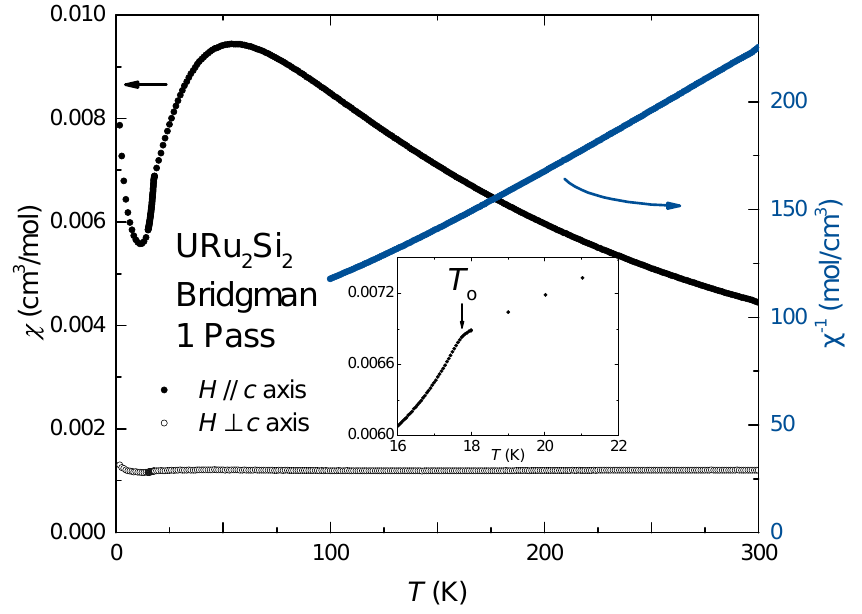
Figure 2. ( left axis ) Magnetic susceptibility χ = M / H vs. temperature T for magnetic field H = 5 kOe applied parallel (cid:107) and perpendicular ⊥ to the c -axis. ( right axis ) Inverse magnetic susceptibility χ − 1 vs. T in the paramagnetic region for URu 2 Si 2 showing Curie–Weiss behavior. ( inset ) χ ( T ) in the region near the hidden order